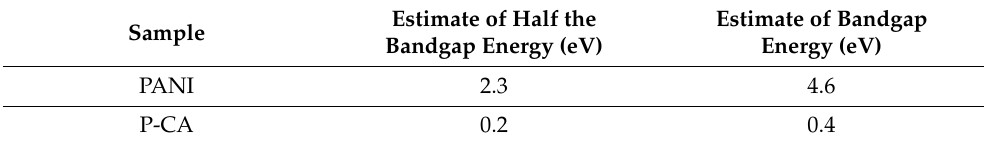
Table 4. Summary of XPS results based on the spectra in the Supplementary Materials (Figure